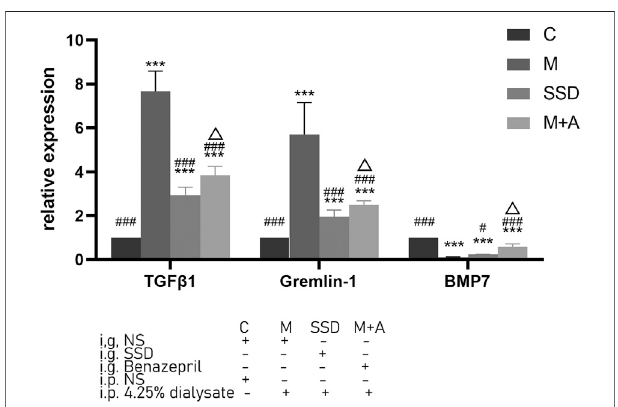
FIGURE 4 | Expression levels of TGF β 1, Gremlin1 and BMP7 of peritoneal tissue by PCR. Data are presented as mean ± SD ( n (cid:2) 3). For comparison with the group C, * indicates p < 0.05 and *** indicates p < 0.001; for comparison with the group M, ### indicates p < 0.001; for comparison with the SSD group, △ indicates p < 0.001.